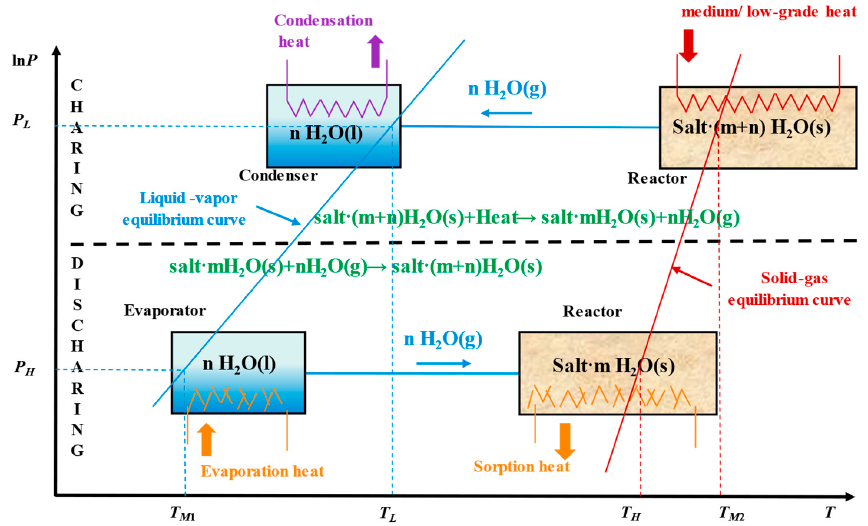
Figure 2. Diagram of Clausius–Clapeyron showing operation principle [13]: Reprinted/adapted with permission from Ref. [13]. 2002, Copyright Clearance Center.